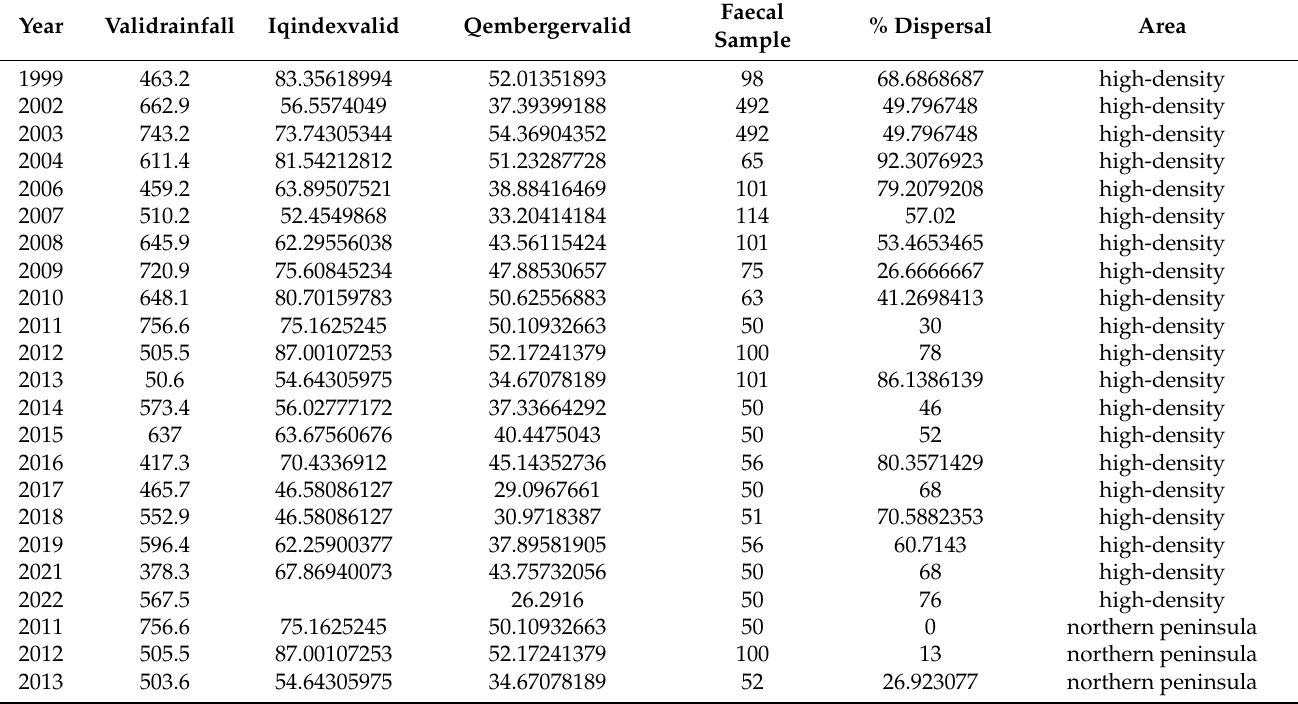
Table A3. Data sheet for long-term study of seed dispersal of the dead horse arum by the Balearic lizard. We show the year, valid rainfall (validrainfall), Iq aridity index (Iqindexvalid), Emberger Q aridity index (Qembergervalid), sample size of faeces examined for the presence of seeds of the dead horse arum (faecal sample), and dispersal intensity as the percentage of faeces with seeds (% dispersal) and area of Aire Island